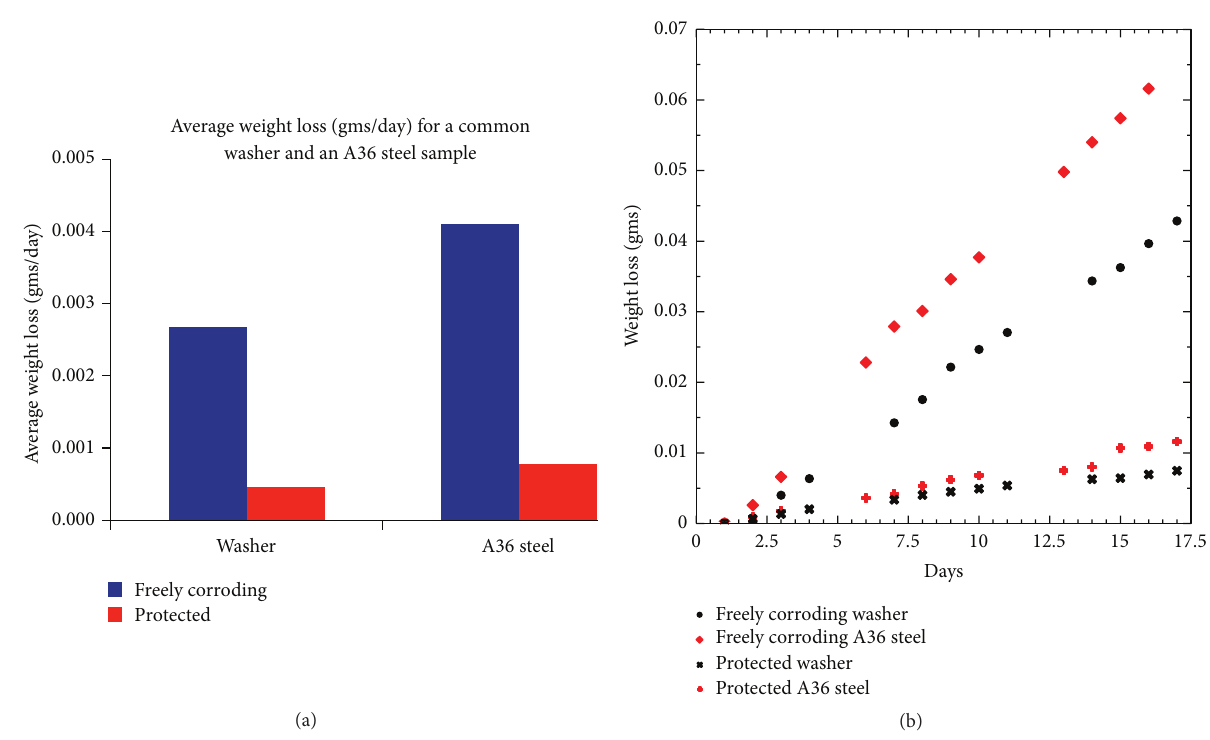
Figure 6: Weight loss of the freely corroding and the protected washer and A36 steel sample. Two different metal samples, a 1 󸀠󸀠 steel washer and an A36 steel metal, are immersed in the 0.6 M NaCl solution for (a) 24 hours and (b) more than two weeks. (a) The weight loss for 24 hours and (b) the weight loss for more than two weeks.